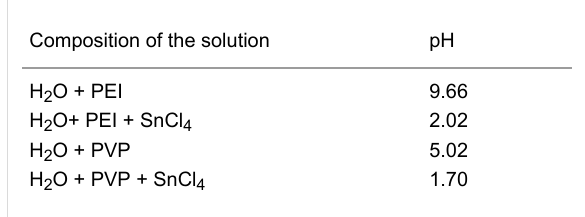
Table 5: pH changes resulting from the stabilising agents and the precursor.